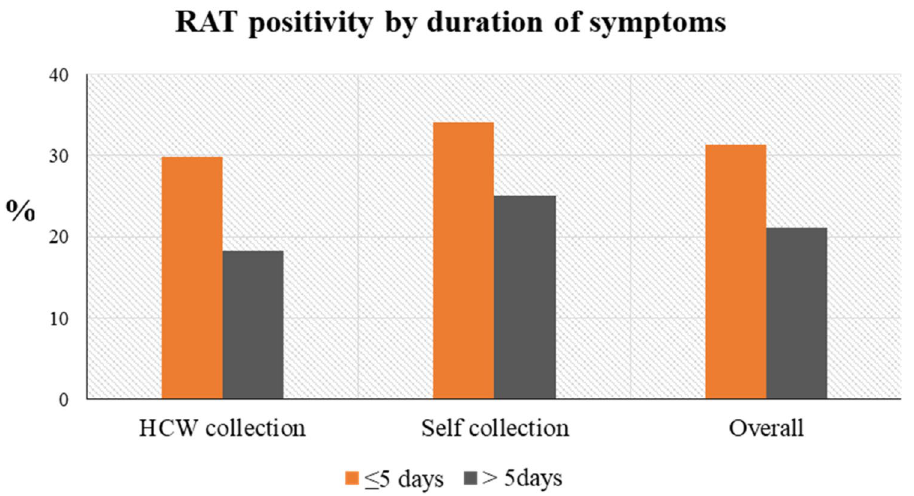
Figure 3. Rapid Antigen Test positivity (RAT) by duration of